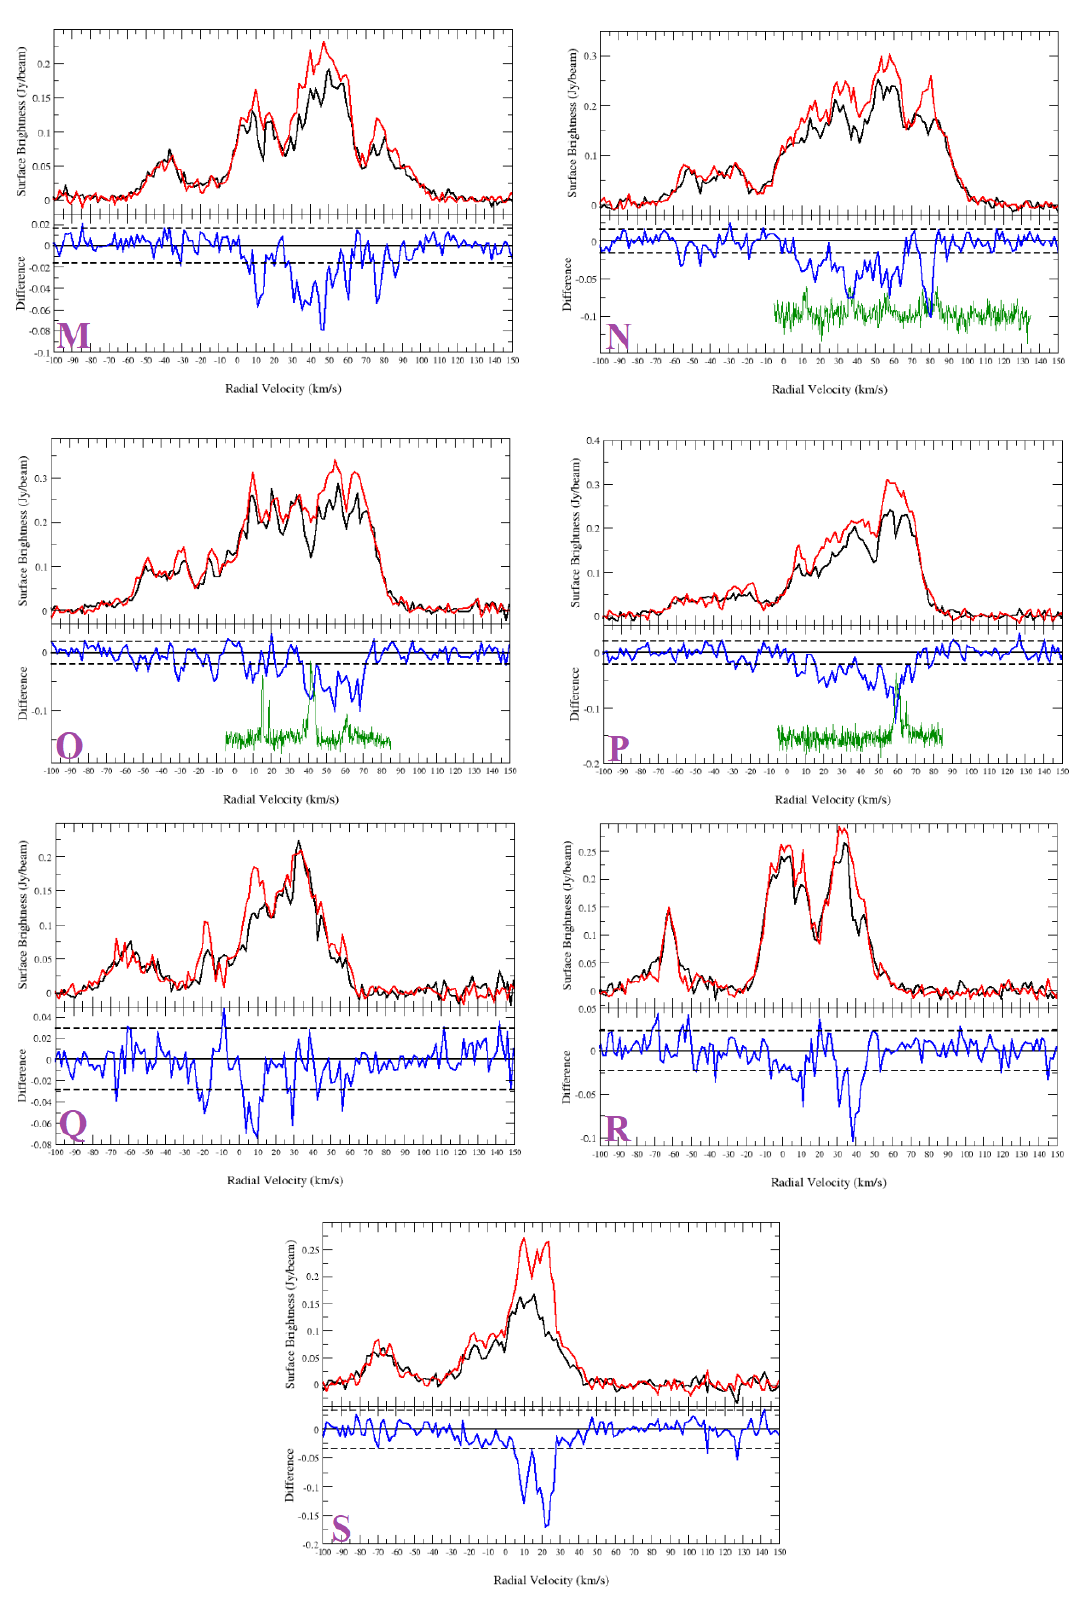
Figure A3. HI spectra of the sources from Sample 2. ( K ) G23.088 + 0.224; ( L ) G24.430 − 1.017; ( M ) G34.421 − 1.031; ( N ) G36.204 − 0.342; ( O ) G43.030 − 0.077; ( P ) G44.324 − 0.730; ( Q ) G56.364 + 0.617; ( R ) G56.608 − 1.105; ( S ) G64.019 − 0.846. Top half of panel: HI emission spectra (source: black and background: red). Bottom half of panel: source—background (difference: blue). The dashed lines are ± 2 σ noise level of the difference. The green curves plotted in the lower halves of the panels are the 13 CO emission